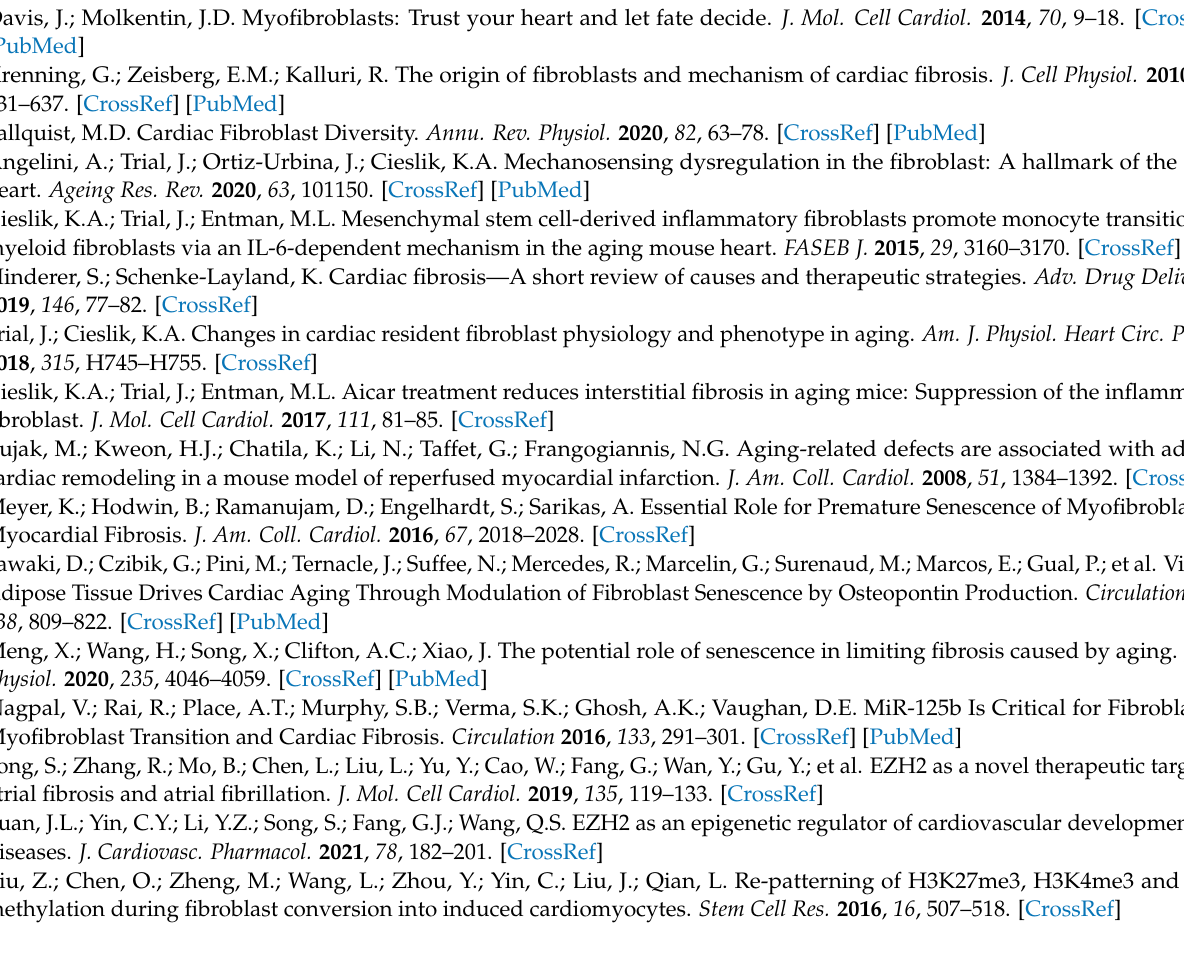
p21; Table S1: Sequences of primers for genes analyzed by qRT-PCR (m-mouse,